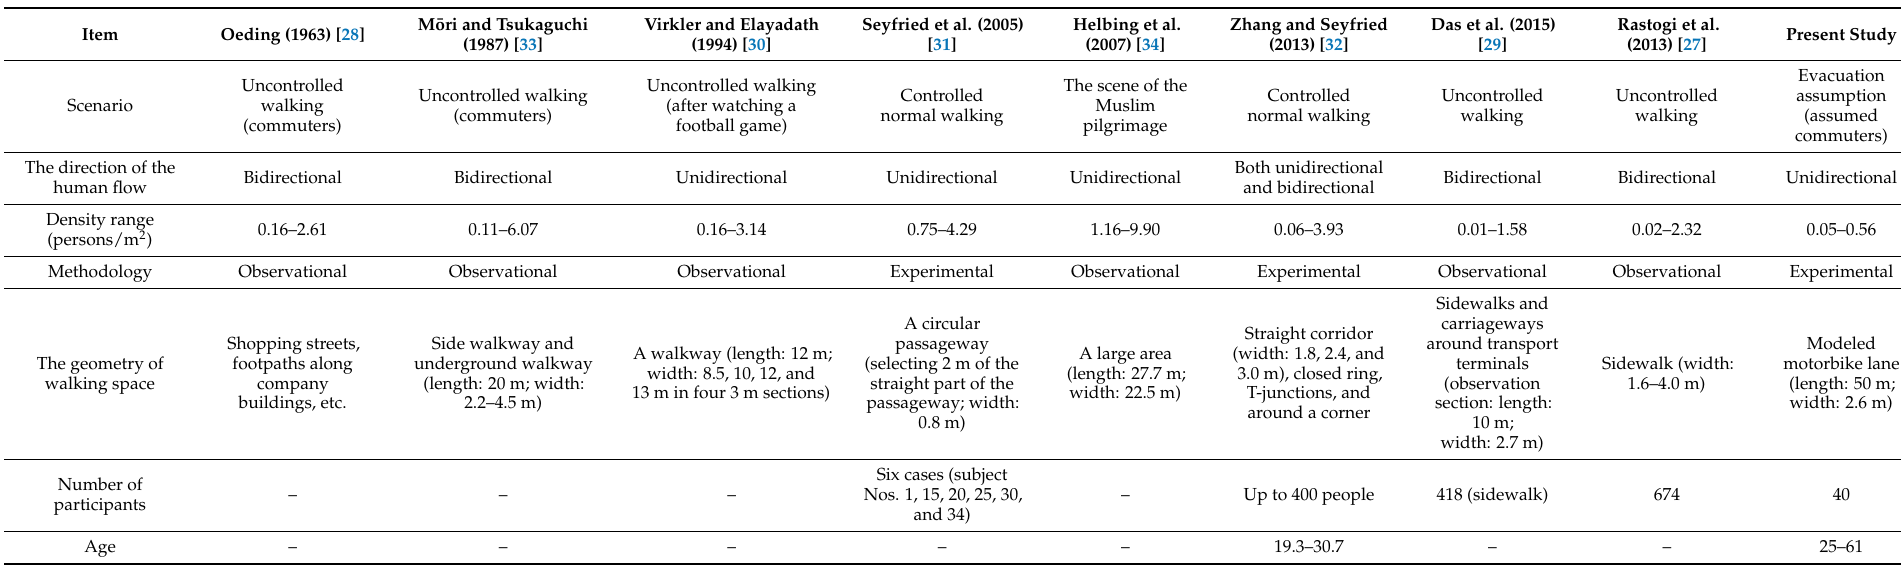
Table 2. Literature review of experimental or observational studies on walking speed and the speed–density